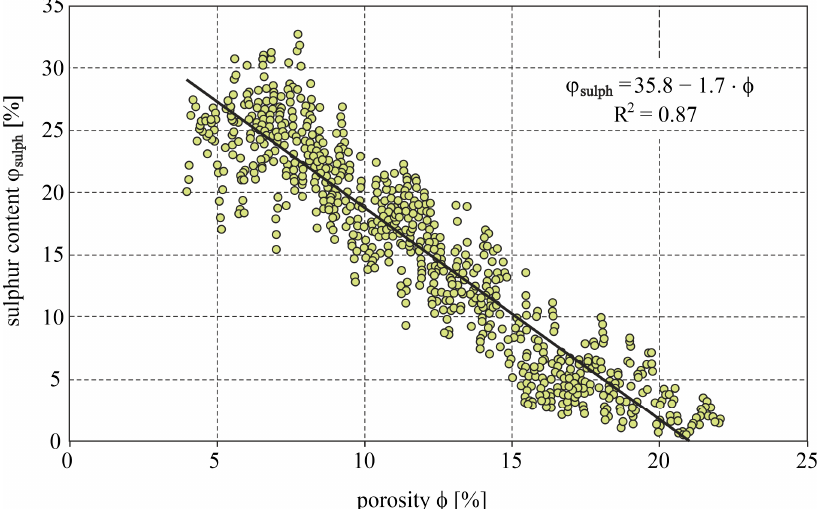
Figure 2. Empirical relationship between porosity and sulphur content within the carbonate deposit estimated from over 50 boreholes from the Osiek area [6,10].